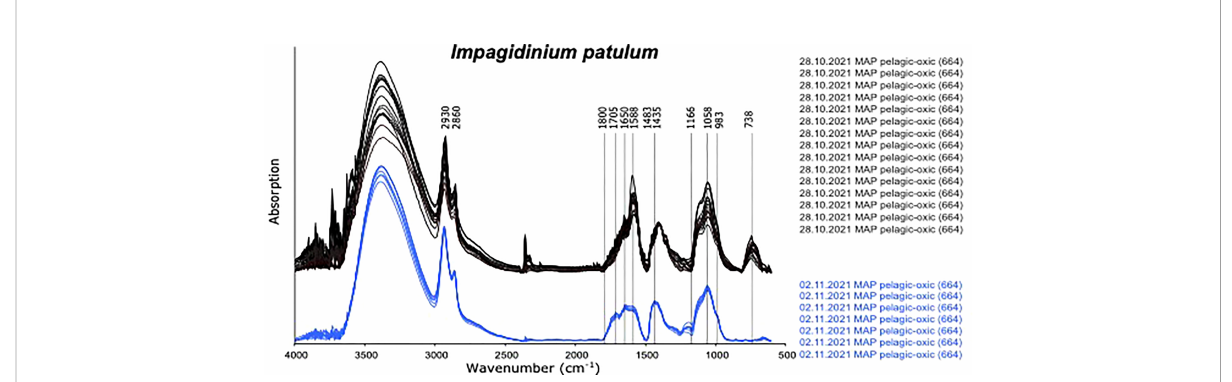
FIGURE 4 Micro-FTIR spectra of Impagidinium patulum measured on 28.10.2021 and 02.11.2022 displaying the effects of different cleaning procedures.